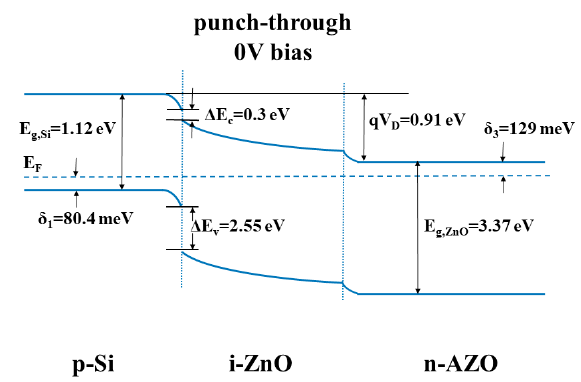
Figure 3. The band diagram of the p-Si/i-ZnO/n-AZO structure.